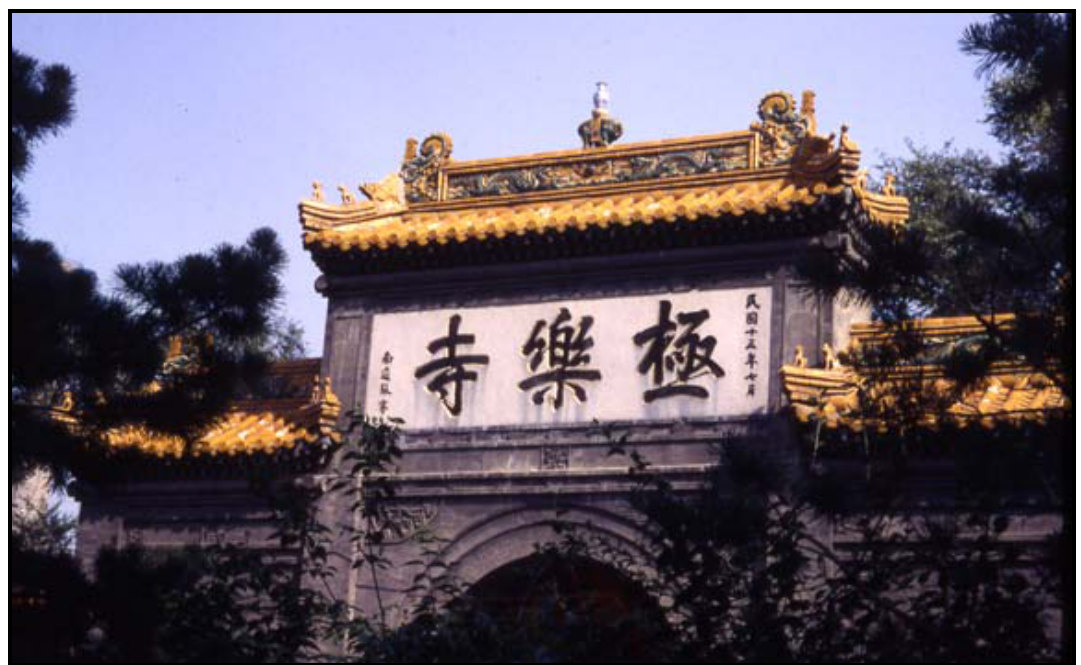
Fig. 2. The traditional Chinese features of Jilesi were a clear contrast with the Russian architecture typical of Harbin at the time it was